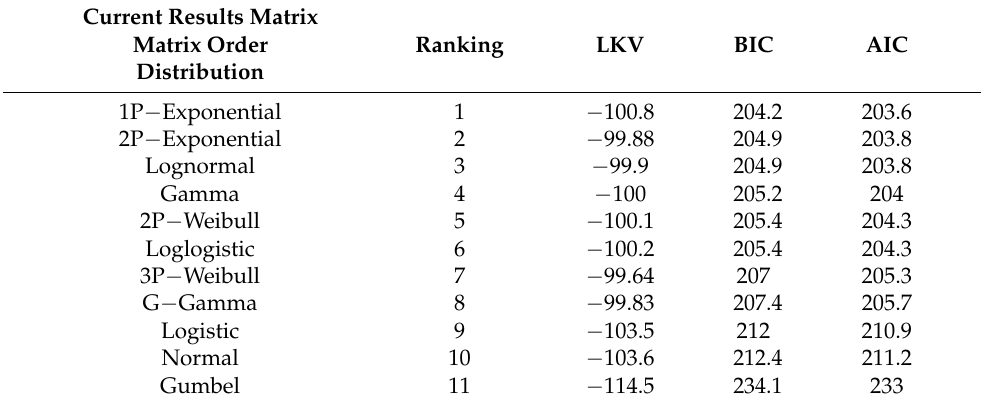
Table 2. Classification of the distribution law acceptance for the captive